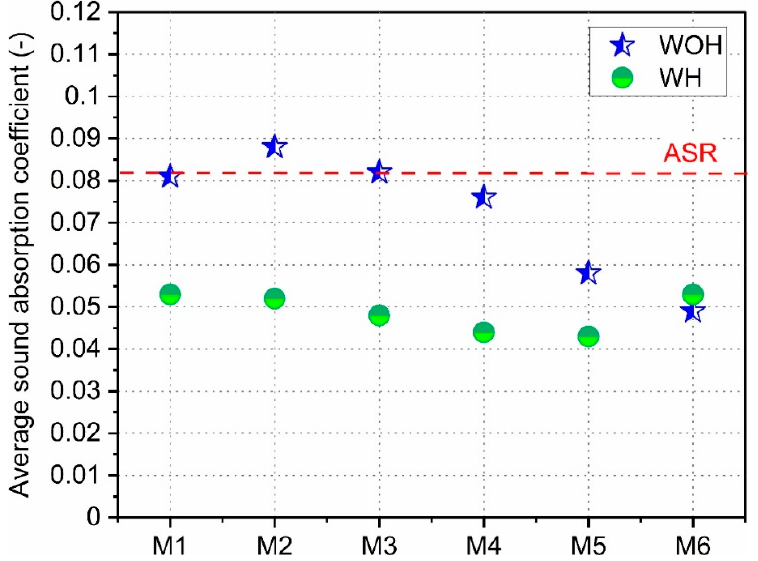
Figure 12. Average sound absorption coefficients of ASR-based materials manufactured with different compatibilization.